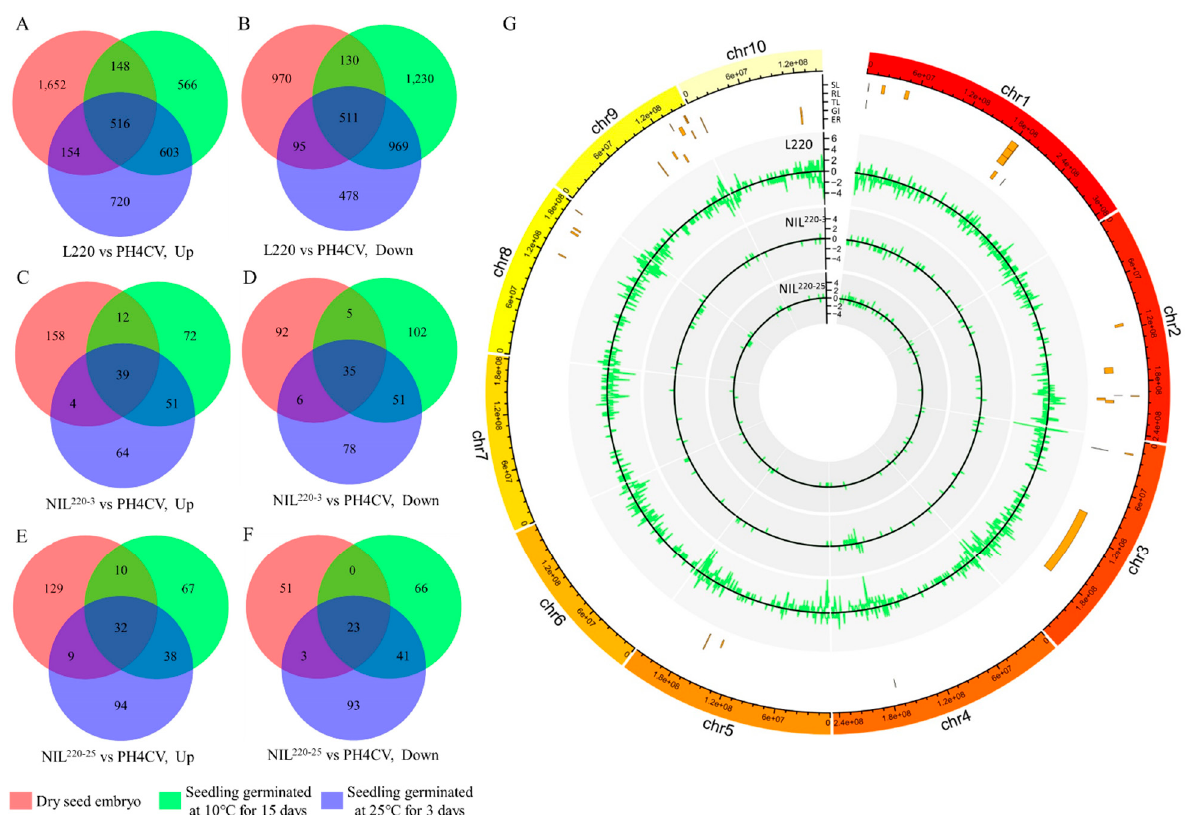
Figure 3. Differentially expressed genes (DEGs) retrieved from L220, NIL 220-3 , and NIL 220-25 as compared to PH4CV at different germination conditions. ( A – F ) Venn diagram illustrating the up- and downregulated DEGs in L220 ( A , B ), NIL 220-3 ( C , D ), and NIL 220-25 ( E , F ) as compared to PH4CV at dry seed embryo stage (red cycle), and seedlings germinated at 25 °C for 3 days (blue cycle) and at 10 °C for 15 days (green cycle). ( G ) Distribution of tolerant line (L220, NIL 220-3 , and NIL 220-25 ) specifically expressed LTGA genes on the maize genome. Circles from outer to inner showed reference genome (B73, AGPv4), QTLs identified for cold germination in a previous study [31], tolerant line (L220, NIL 220-3 , and NIL 220-25 ) specifically expressed gene number in the 1 Mb bin region. Positive or negative numbers indicated up- or downregulated genes.